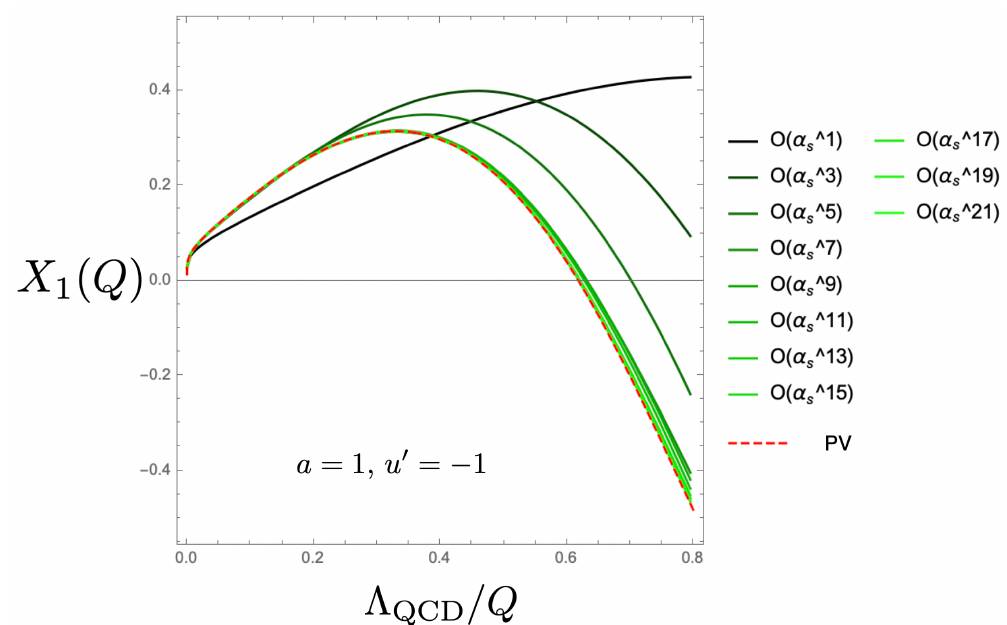
Figure 4 . Comparison of the PV prescription (dashed red line) and the FTRS method for X 1 ( Q ) (green lines with gradation). We set b 0 = 1 . In the momentum space, we truncate the series at O ( α k +1 ) for k = 1 , · · · , 21 . s Figure 5 . Comparison of the behavior of the ambiguous part δX 1 ( Q ) calculated by the con- tour integral in the Borel plane [eq. (2.8)] (dashed red line) and the FTRS method (green lines with gradation). We set b 0 = 1 . In the momentum space, we truncate the series at O ( α k +1 for k = 1 , · · · , 21